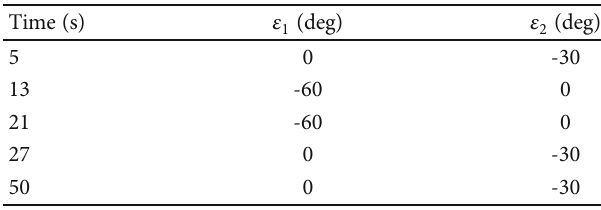
Table 4: Variation of two joint angles.